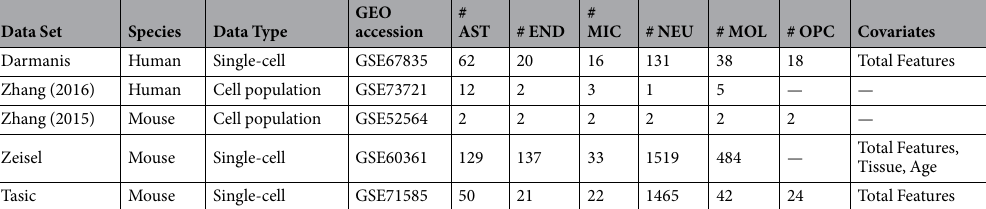
Table 1. Summary of RNA expression data sets used in this analysis. The sample size for each cell type, as well as the covariates included in the differential expression model, for each of the data sets used in this meta- analysis. Note that these numbers are calculated subsequent to cleaning and combining of cell populations originally annotated in each of the data sets, as described in the Methods. A dash indicates that a cell type was not present in that data set. AST = astrocyte, END = endothelial cell, MIC = microglia, NEU = neuron, MOL = mature oligodendrocyte, OPC = oligodendrocyte precursor